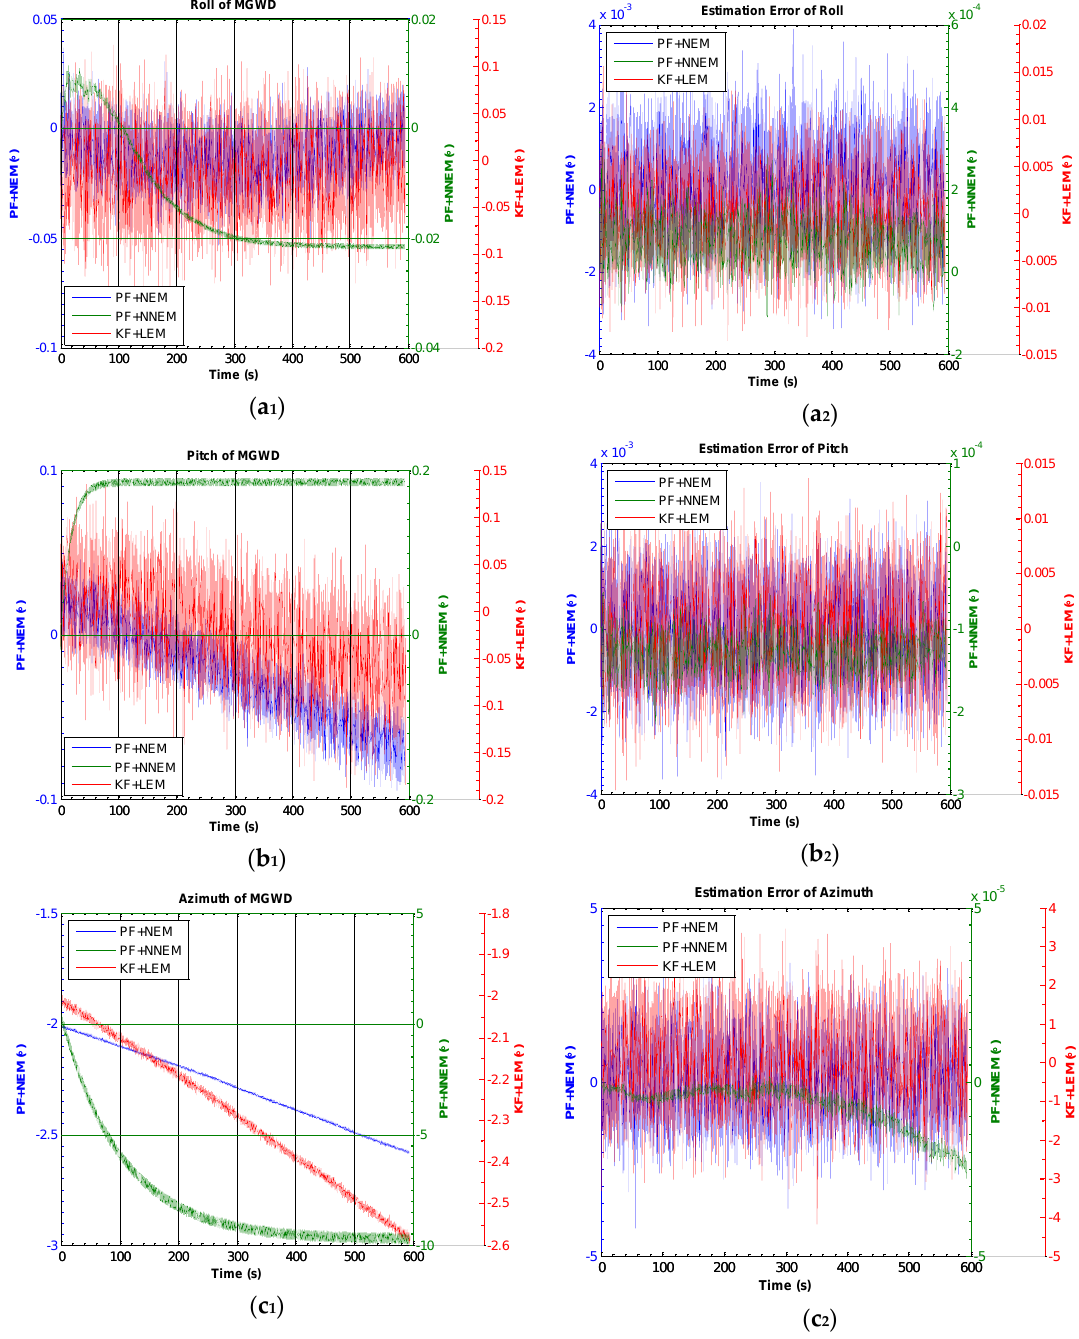
Figure 10. Results of attitude and estimation error of attitude by KF with LEM, PF with NEM, and PF with NNEM under large-angle attitude error conditions. ( a 1 ) and ( a 2 ) are the estimation of roll and estimation error of roll; ( b 1 ) and ( b 2 ) are the estimation of pitch and estimation error of pitch; ( c 1 ) and ( c 2 ) are the estimation of azimuth and estimation error of azimuth. Plotting the figure uses the triple Y-axis plotting approach because the results are in different orders of magnitude.